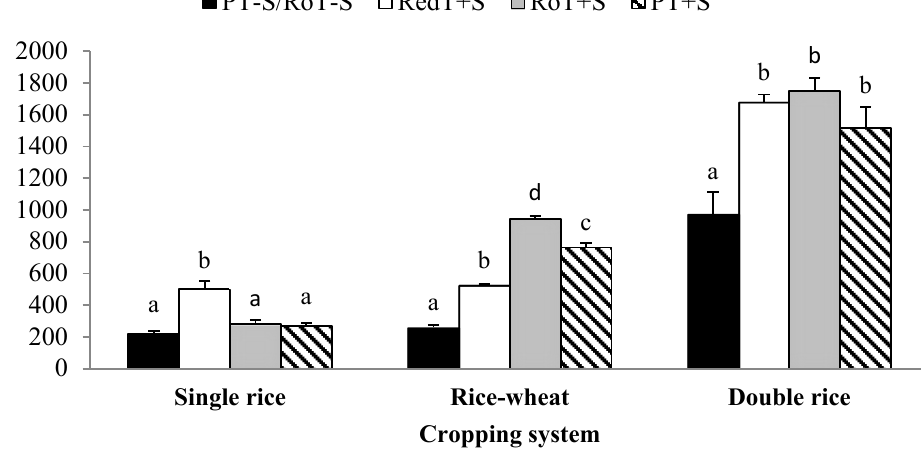
Figure 3. Impacts of straw incorporated tillage patterns on cumulative CH 4 emission in the three cropping systems. Different letters within the same column indicate significant differences among treatments at a 0.05 probability level in each cropping system.